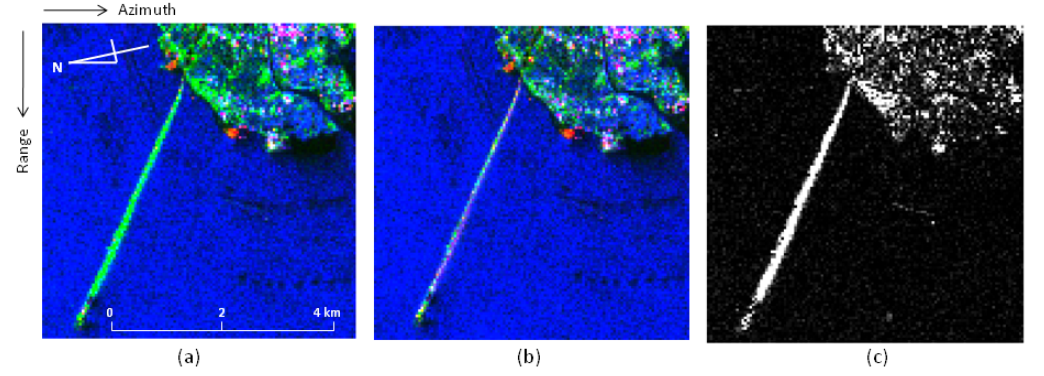
Figure 6. Tokyo Bay Aqua-Line (Highway) near the area of Figure 2. ( a ) Rotation angle